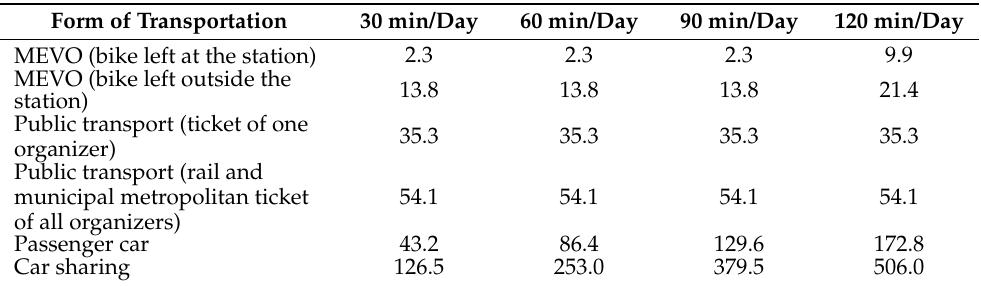
Table 7. Monthly costs of urban trips made by particular forms of transportation within the analyzed area (EUR per month).